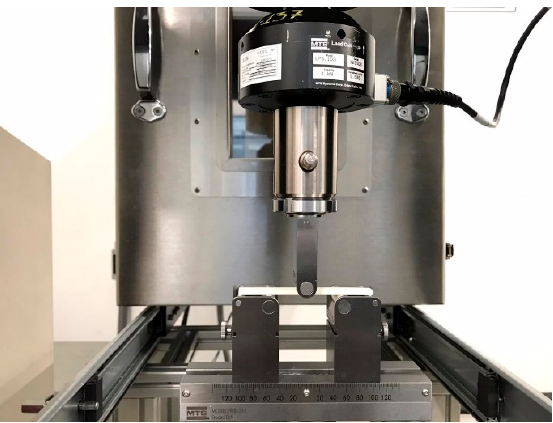
Figure 1. ( a ) MDS Nordion Gammacell 220 Excel irradiator (courtesy of UNISON, México); ( b ) ZnO- epoxy composite samples before (white) and after (brown) UV and gamma irradiation.